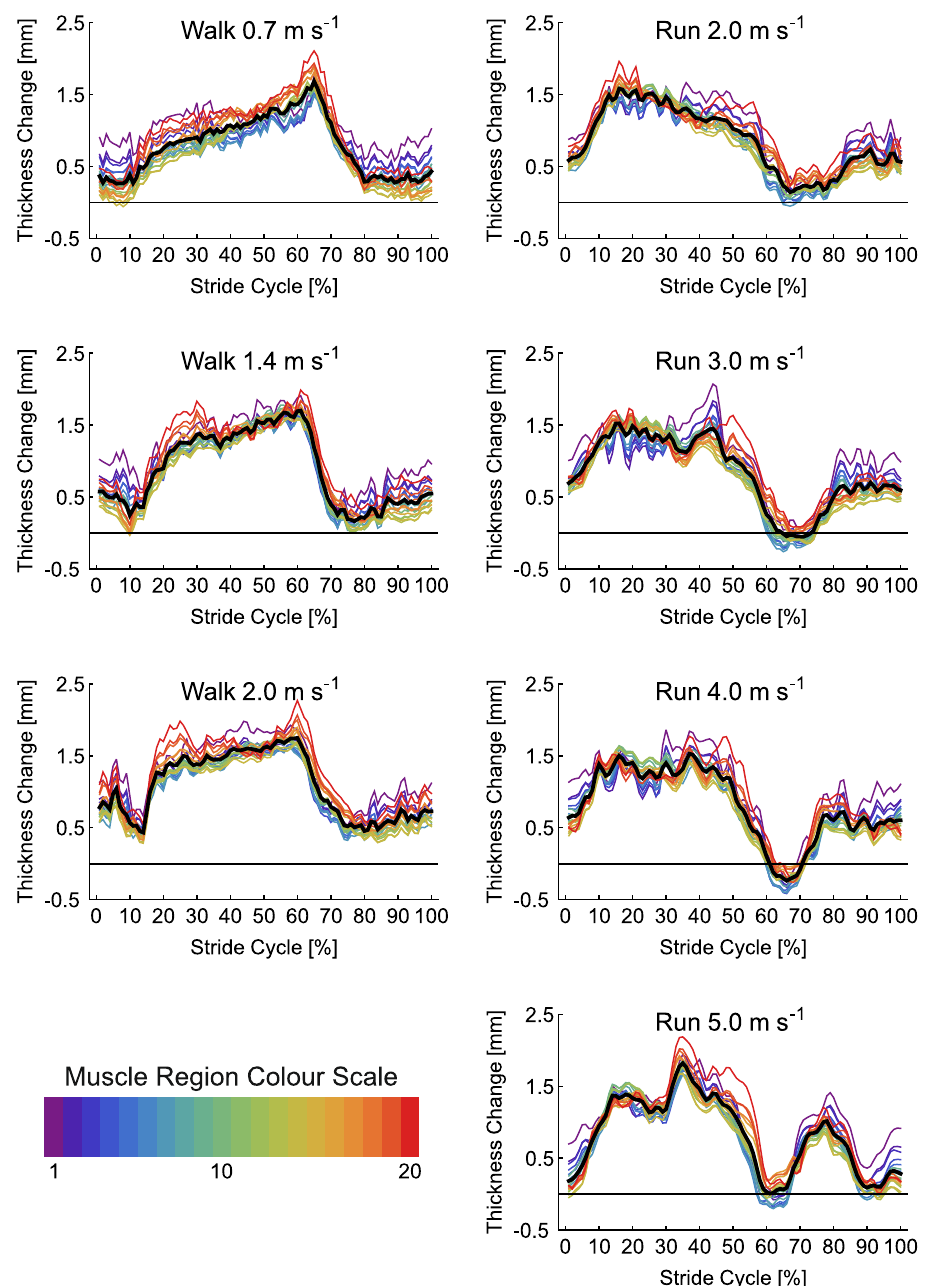
Figure 2. Change in thickness of soleus muscle a function of stride cycle for each of the seven locomotor conditions studied. Twenty coloured lines represent the change in thickness at each point along the length of the muscle (see colour scale bar and Fig. 1). The thick black line represents the mean value. Thickness change was calculated as the thickness subtracted from the thickness recorded during a quiet standing